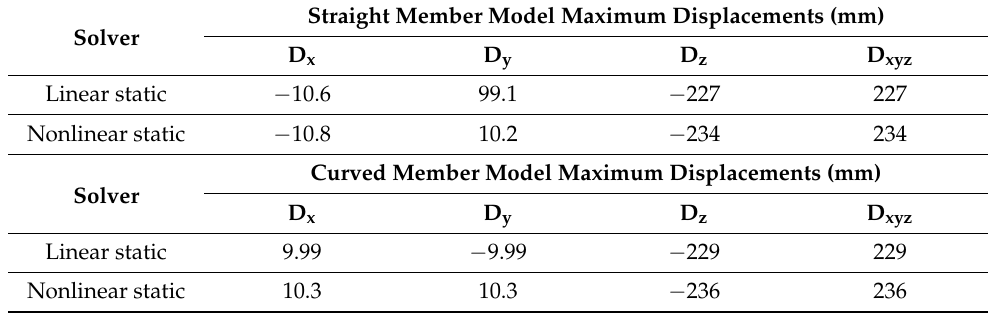
Table 7. Displacements under 1.35G.